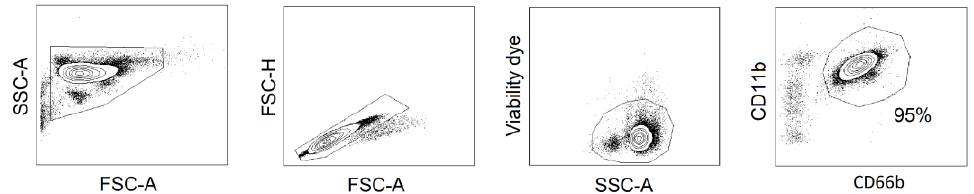
Figure A3. Purity of human peripheral blood neutrophils (single viable CD11b + /CD66b + cells) isolated from the whole blood by the density gradient.